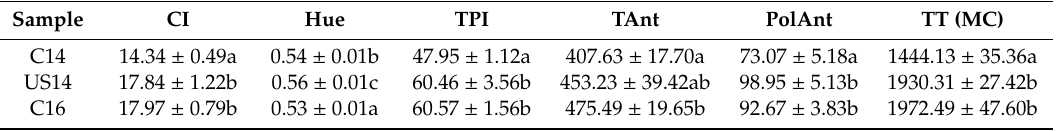
Table 2. Chromatic and phenolic characteristics of the studied